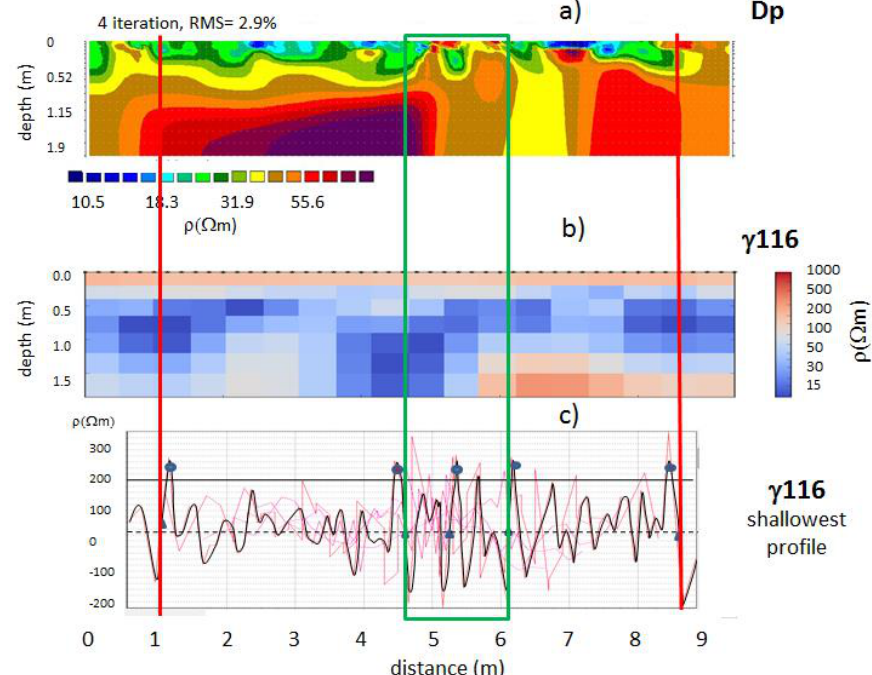
Figure 9. Fault zone characterization: ( a ) Dp electrical resistivity tomography (ERT) section; ( b ) γ 116 ERT section; ( c ) the near-surface apparent resistivity profile measured by the γ 116 array, green rectangle delineates the fracture zone according to the γ 116 profile, red lines mark two other main fractures (Section 3.1.3).